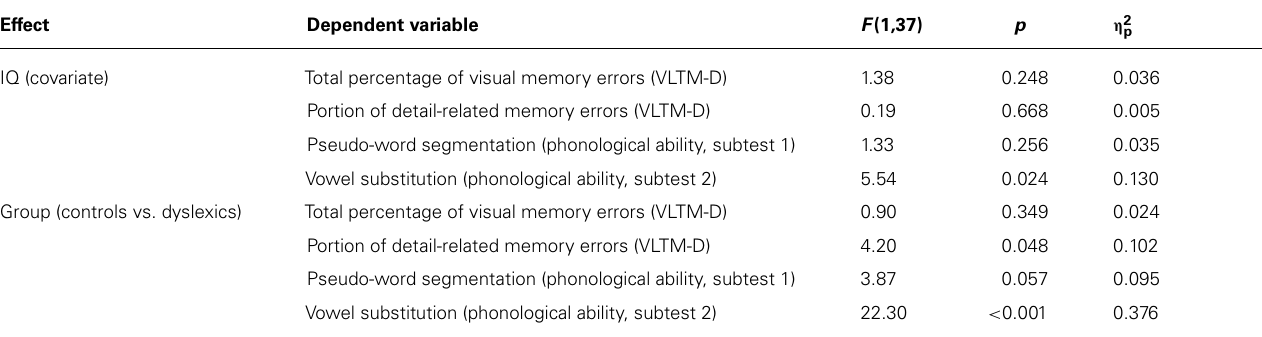
Table 3 |Analysis of variance results for the (marginally significant) covariate IQ and the group factor (see MANCOVA